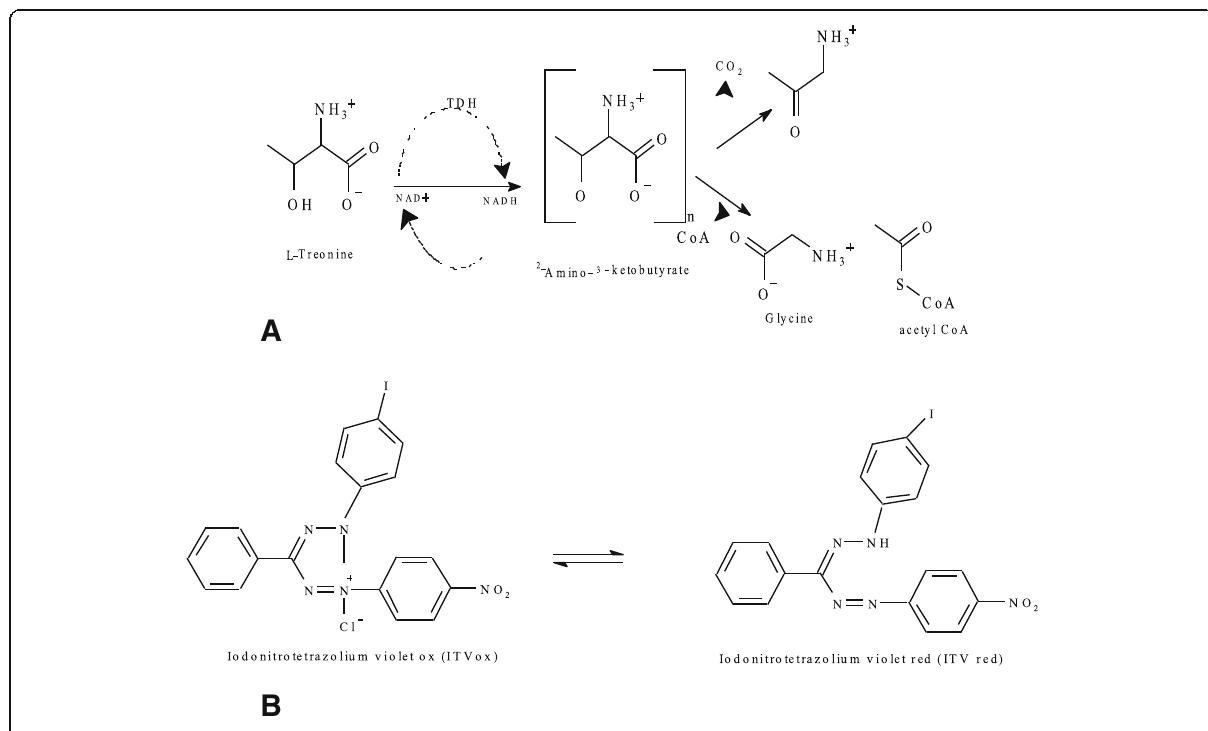
Fig. 1 a Reaction pathways for the assay of threonine dehydrogenase, b INT, coupling reagent for the colorimetric